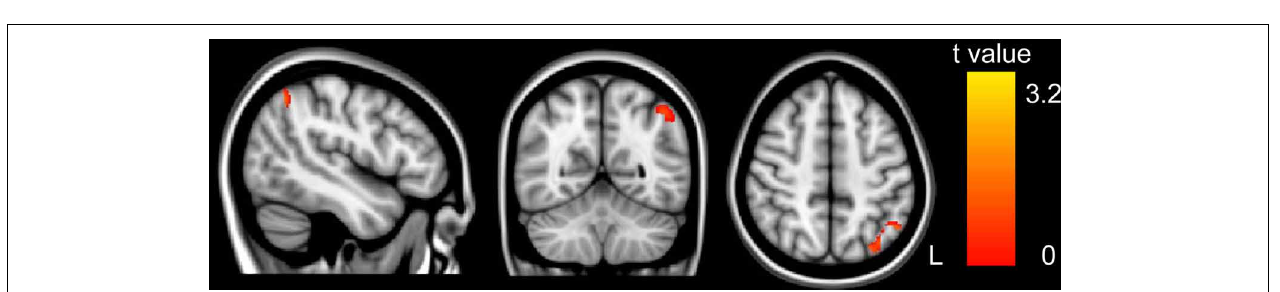
FIGURE 1 | The correlation between GM volume and WISC-RC arithmetic scores. Positive correlation between GM volume and WISC-RC arithmetic scores in the left IPS. The location of the significantly correlated cluster was shown in red-yellow. The color intensity represents the